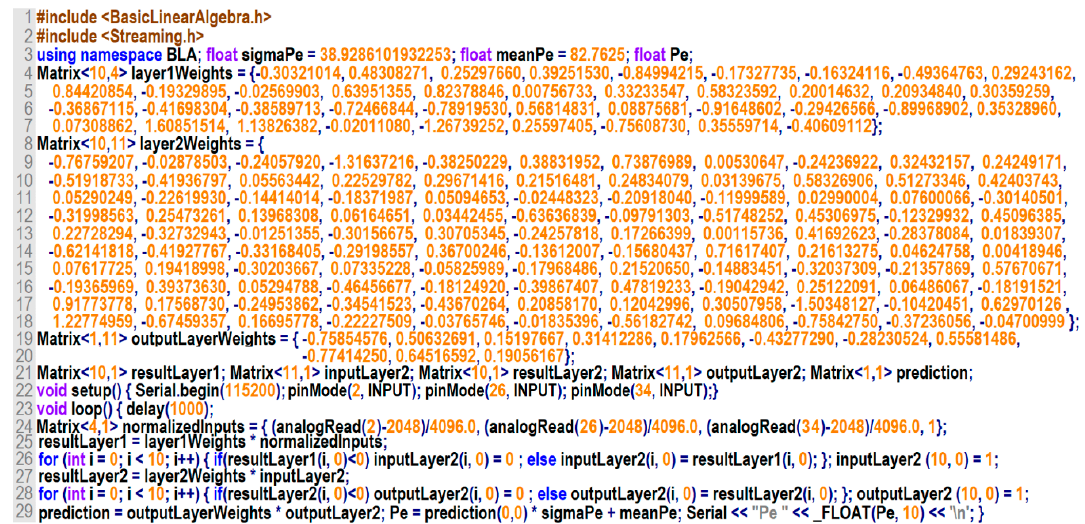
Figure 17. The Arduino code (of the compact “edge AI” smart device) with embedded ANN coefficients.